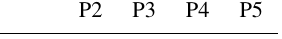
Table 4. Percentage wake loss for participants P2–P5 in the high-price scenario for 2020 and 2030, i.e. ( P gross − P Normal Operation ) /P gross , where P gross is the theoretical gross pro- duction without wake losses and P Normal Operation the normal pro- duction without WFFC simulated by each participant. P2 P3 P4